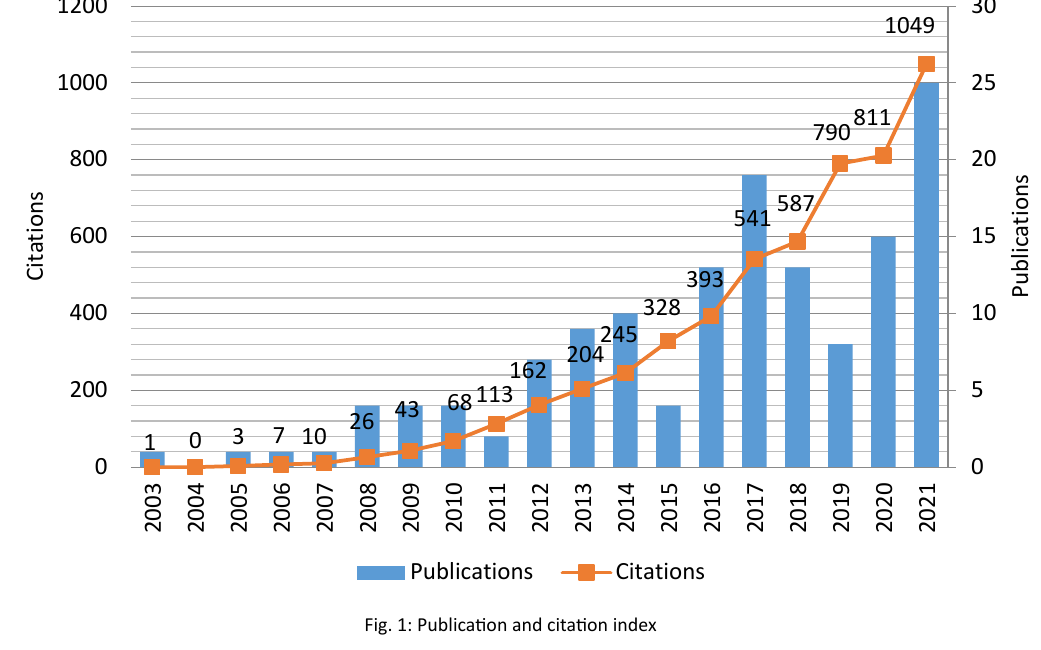
Fig. 1: Publication and citation index